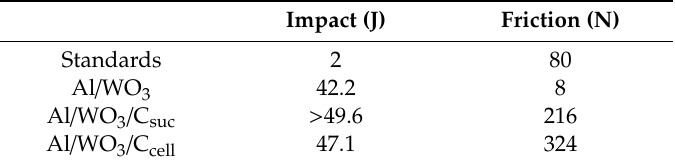
Table 2. Mechanical (impact and friction) sensitivity thresholds for the Al / WO 3 / C nanothermites (weight % of carbon of approximately 2.7 and 2.4 from sucrose and cellulose as the carbon sources,